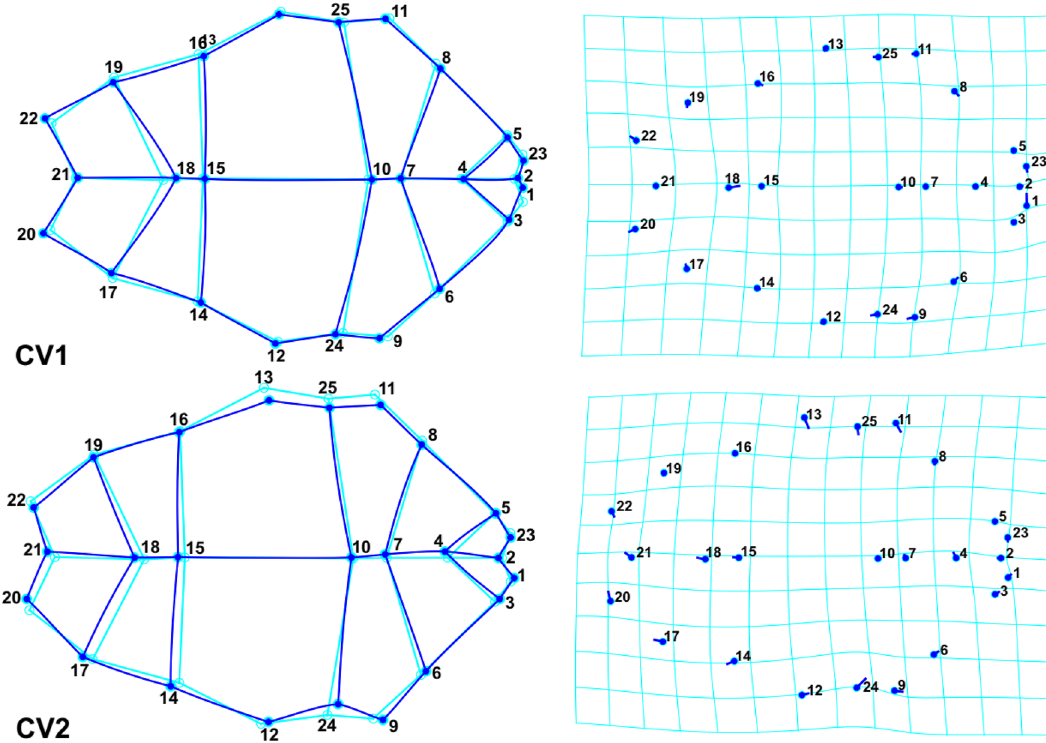
Figure 9. Plastron shape variation of T. graeca populations defined by transformation grids (right) and wireframe graphs (left) of the first two canonical axes in Central Iran.